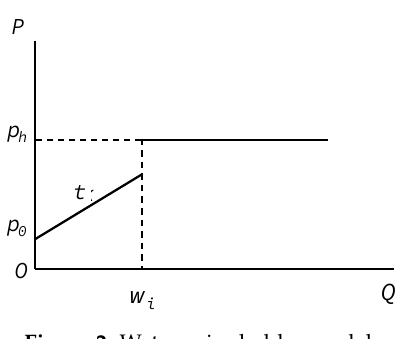
Figure 2. Water price ladder model.